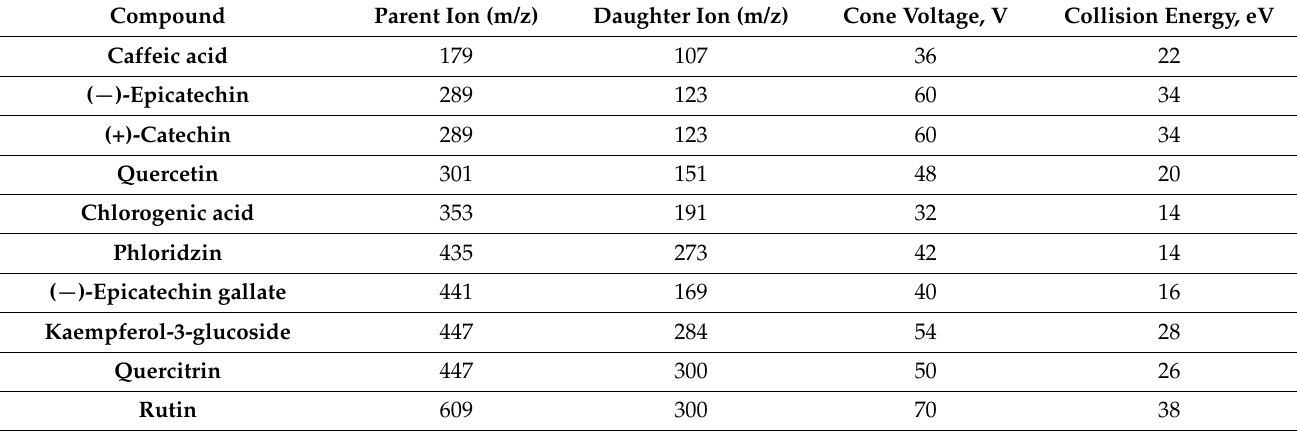
Table 1. Mass spectrometry parameters for the analysis of phenolic